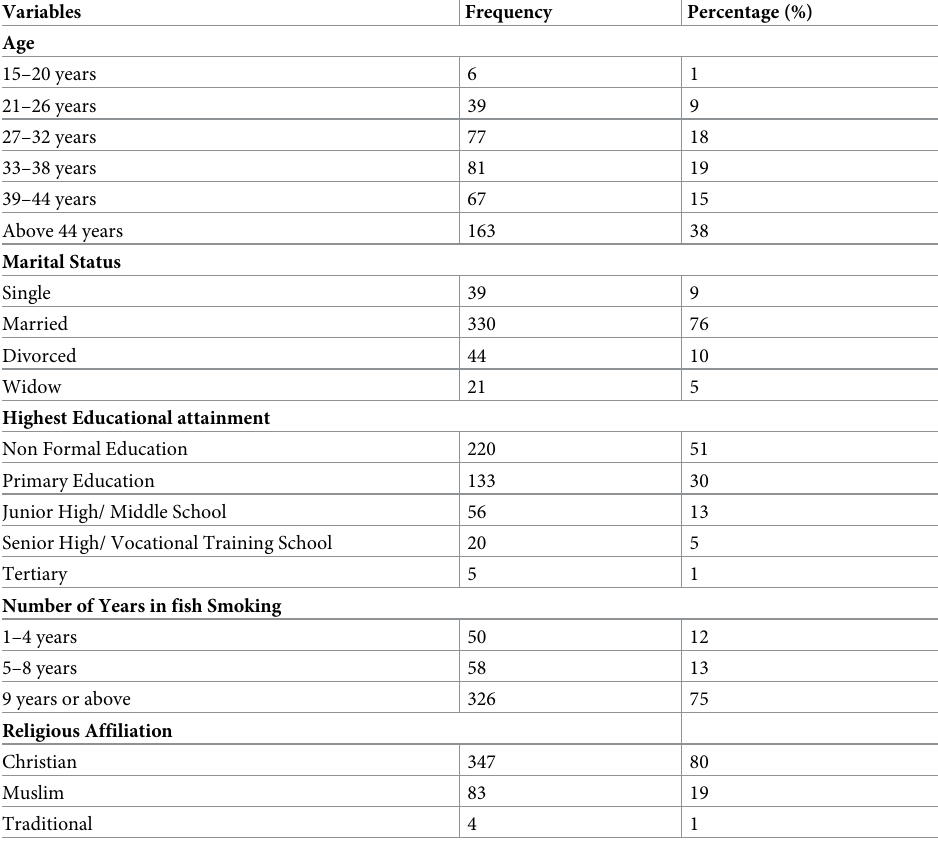
Table 1. Summary characteristics of respondents (N = 434).